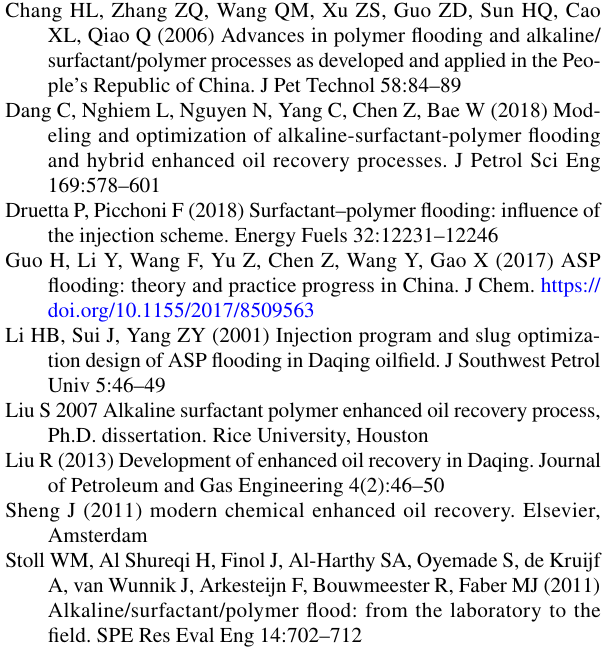
Fig. 19 Recovery performance comparisons of different injection